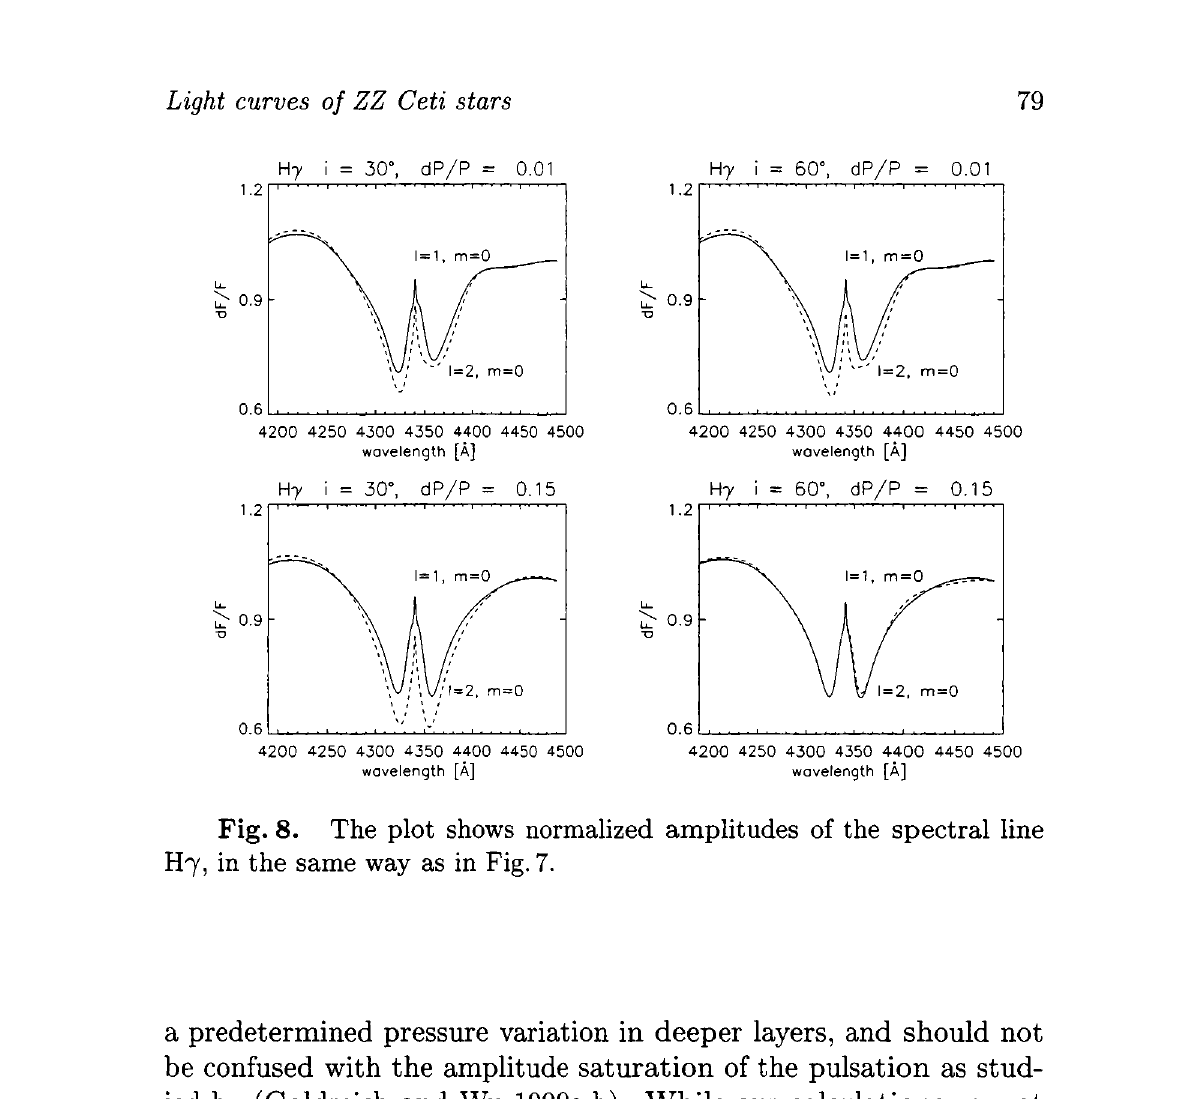
Fig. 8. The plot shows normalized amplitudes of the spectral line H7, in the same way as in Fig.